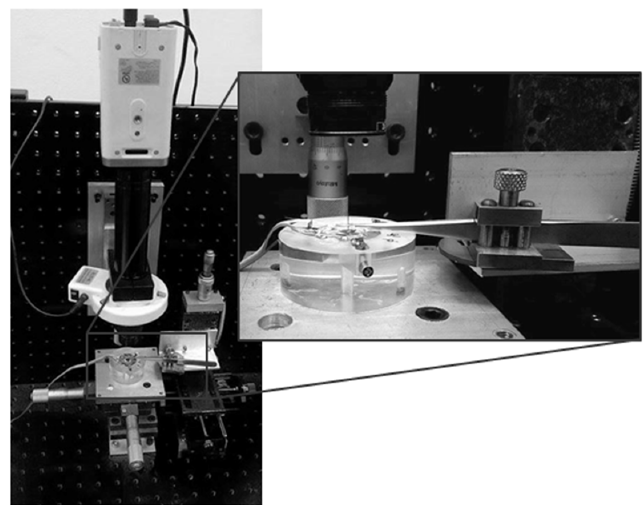
Figure 4. Manual assembly process for the tri ‐ switches probing head.